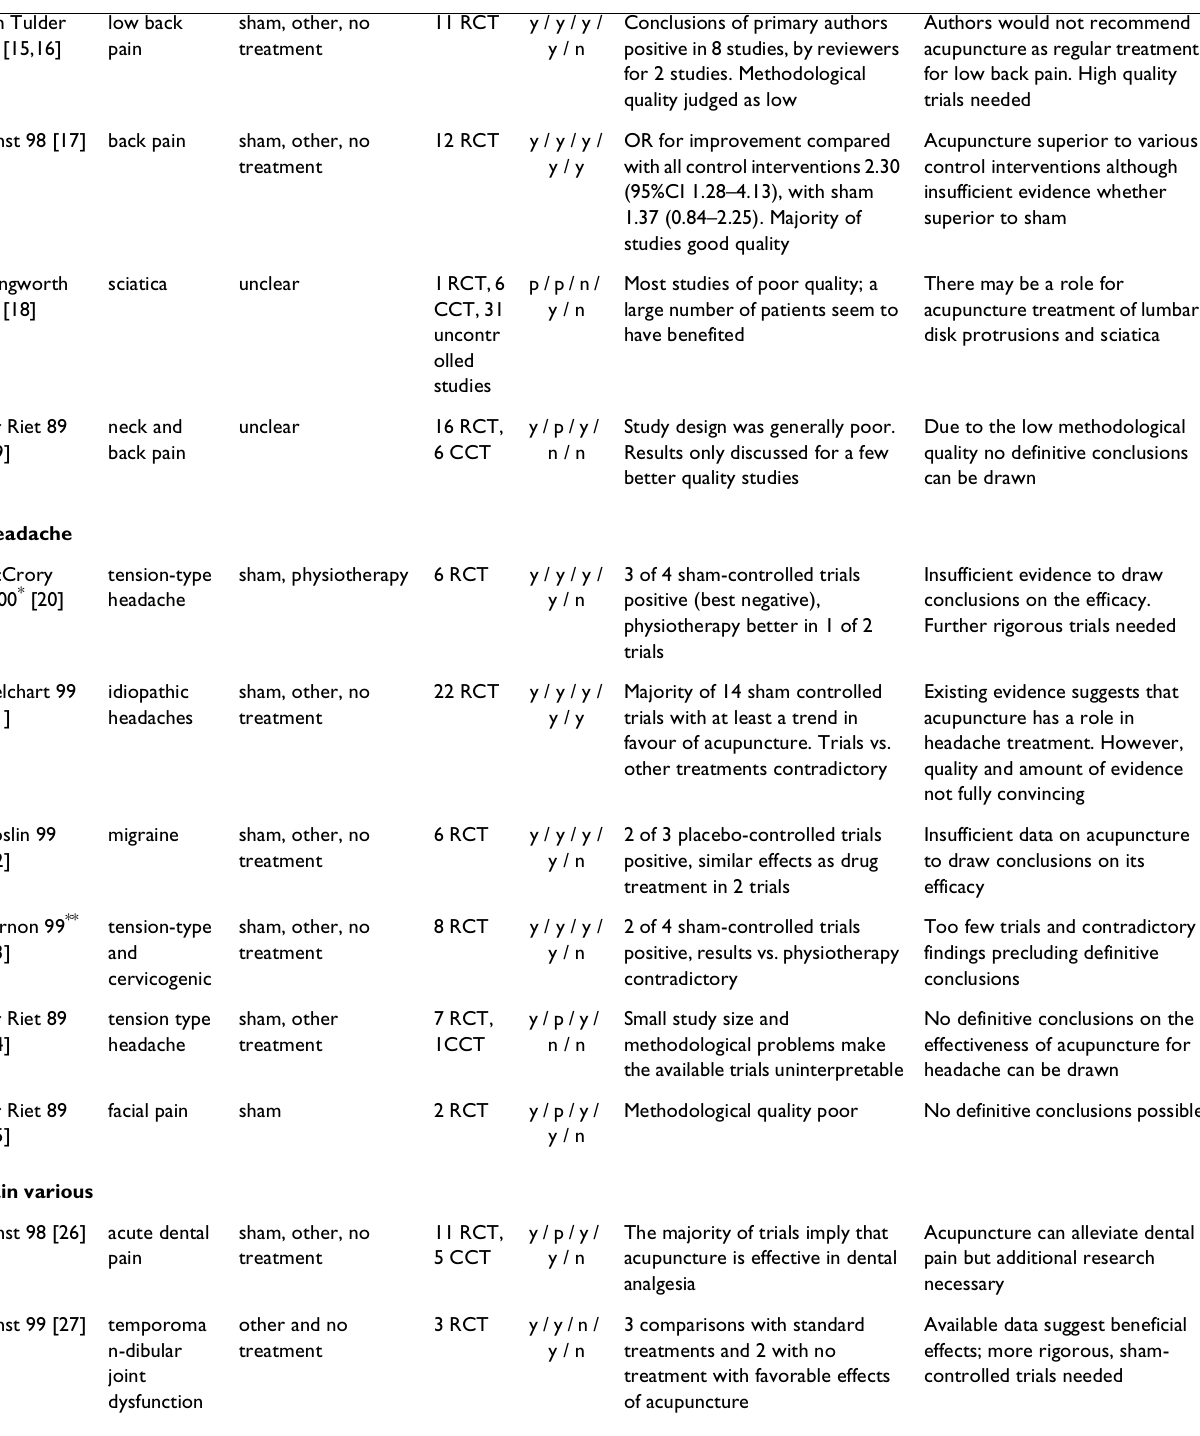
Table 1: Systematic reviews of clinical trials of acupuncture & acupressure in pain